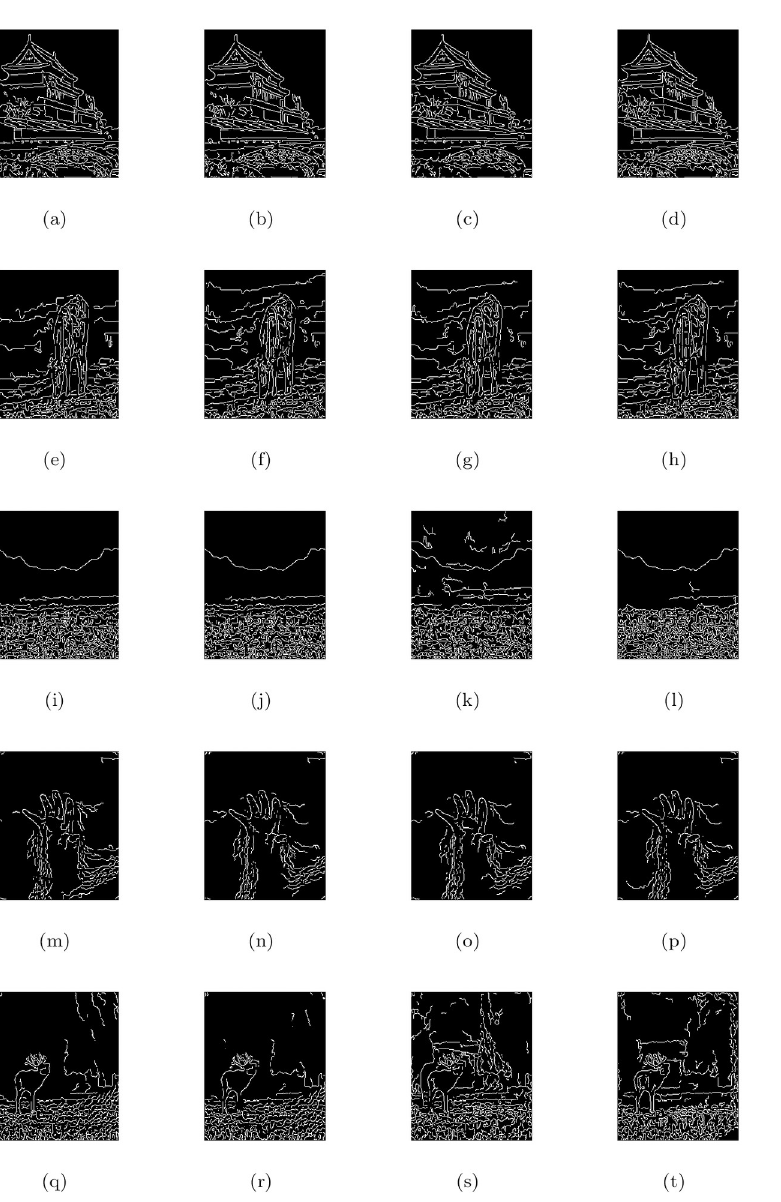
Fig 6. Corresponding visible edge maps of Fig